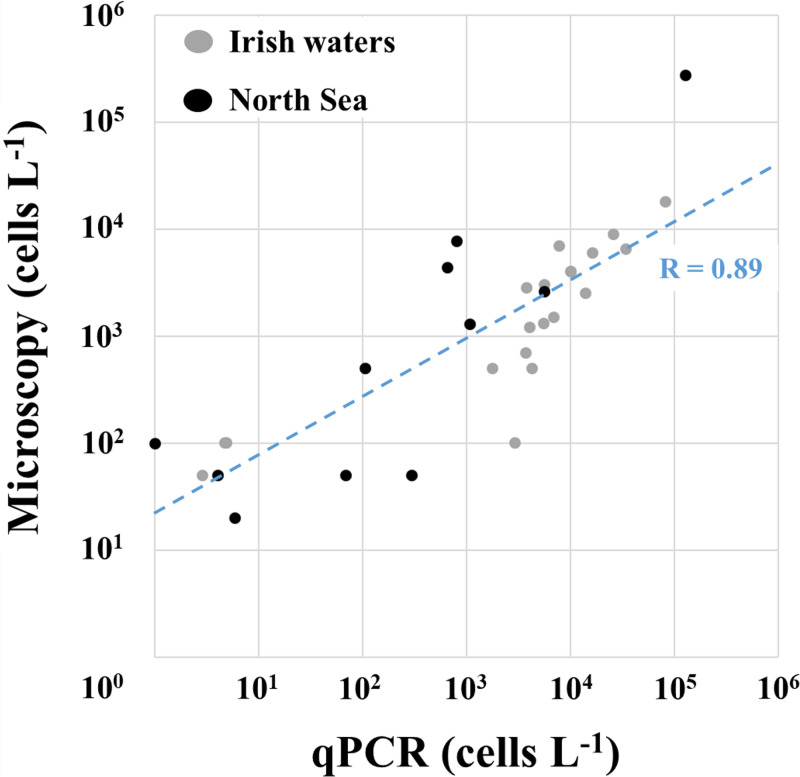
Correlation between microscopic (x-axis) and qPCR (y-axis) calculated cell numbers L-1.Dots indicate the sample area of either Irish waters (grey) or the North Sea (black). “R” displays the respective correlation coefficient.